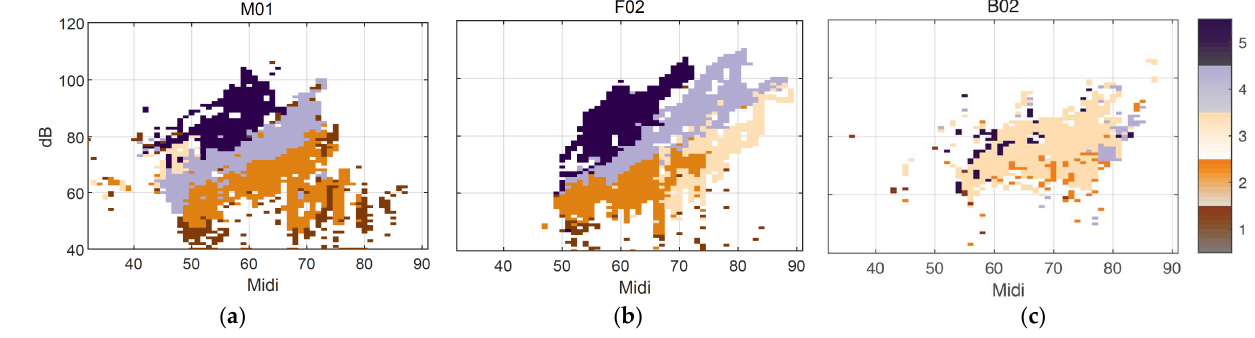
Figure 6. Examples of using k = 5 clusters, on individual full voice range voice maps (VRPs) on /a:/ vowel ( a ) VRP of male participant M01; ( b ) VRP of female participant F02; ( c ) VRP of child (boy) participant B02. The color plotted in any given cell is that of the most frequently occurring phonation type in the cell, i.e., the dominant cluster. Each cell may contain cycles from other clusters as well, but such overlap is not visualized here. The x -axis is f o in semitones (on the MIDI scale, 48 = 110 Hz), and the y -axis is SPL in dB(C) at 0.3 m.